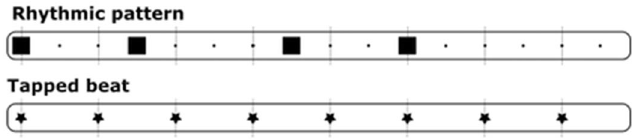
Figure 3. Rhythmic pattern used in control experiment 2. Figure was created using Inkscape 1.1 (https:// inksc ape.